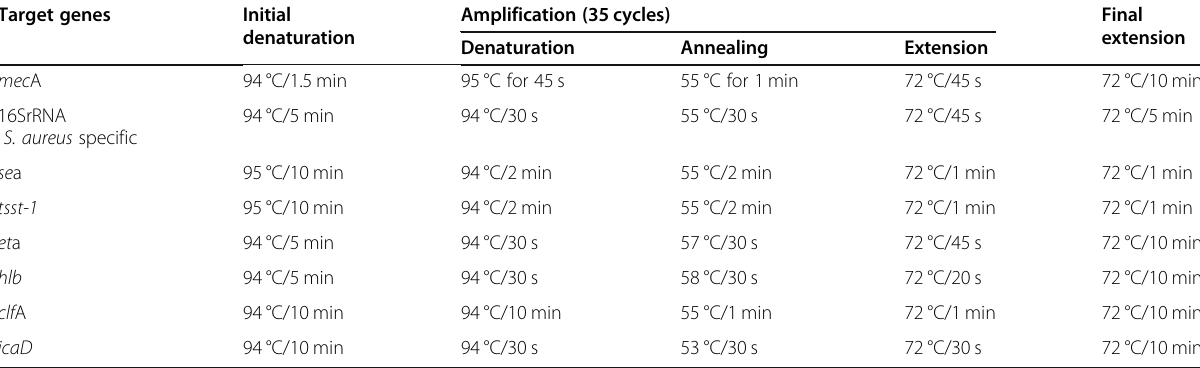
Table 2 Cyclic polymerase chain reaction conditions of the different primer sets Target genes